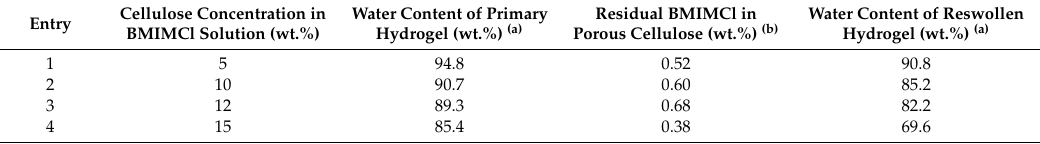
Table 1. Water contents of hydrogels and the residual BMIMCl amounts in porous celluloses.